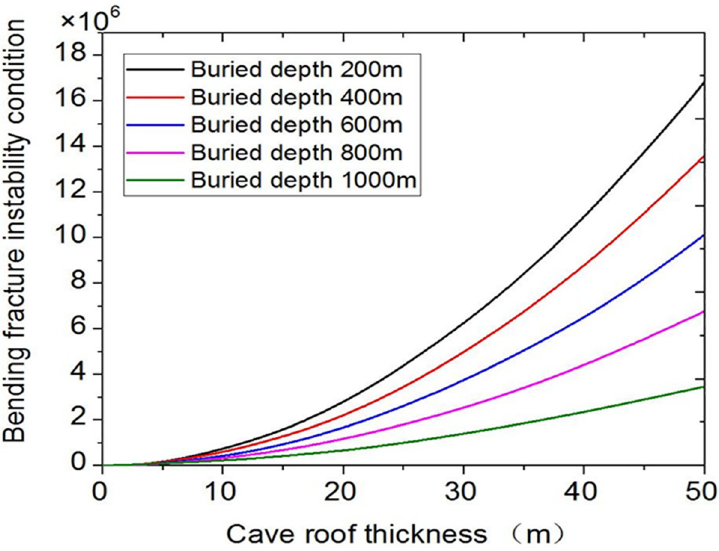
Fig 6. Influence curves of different buried